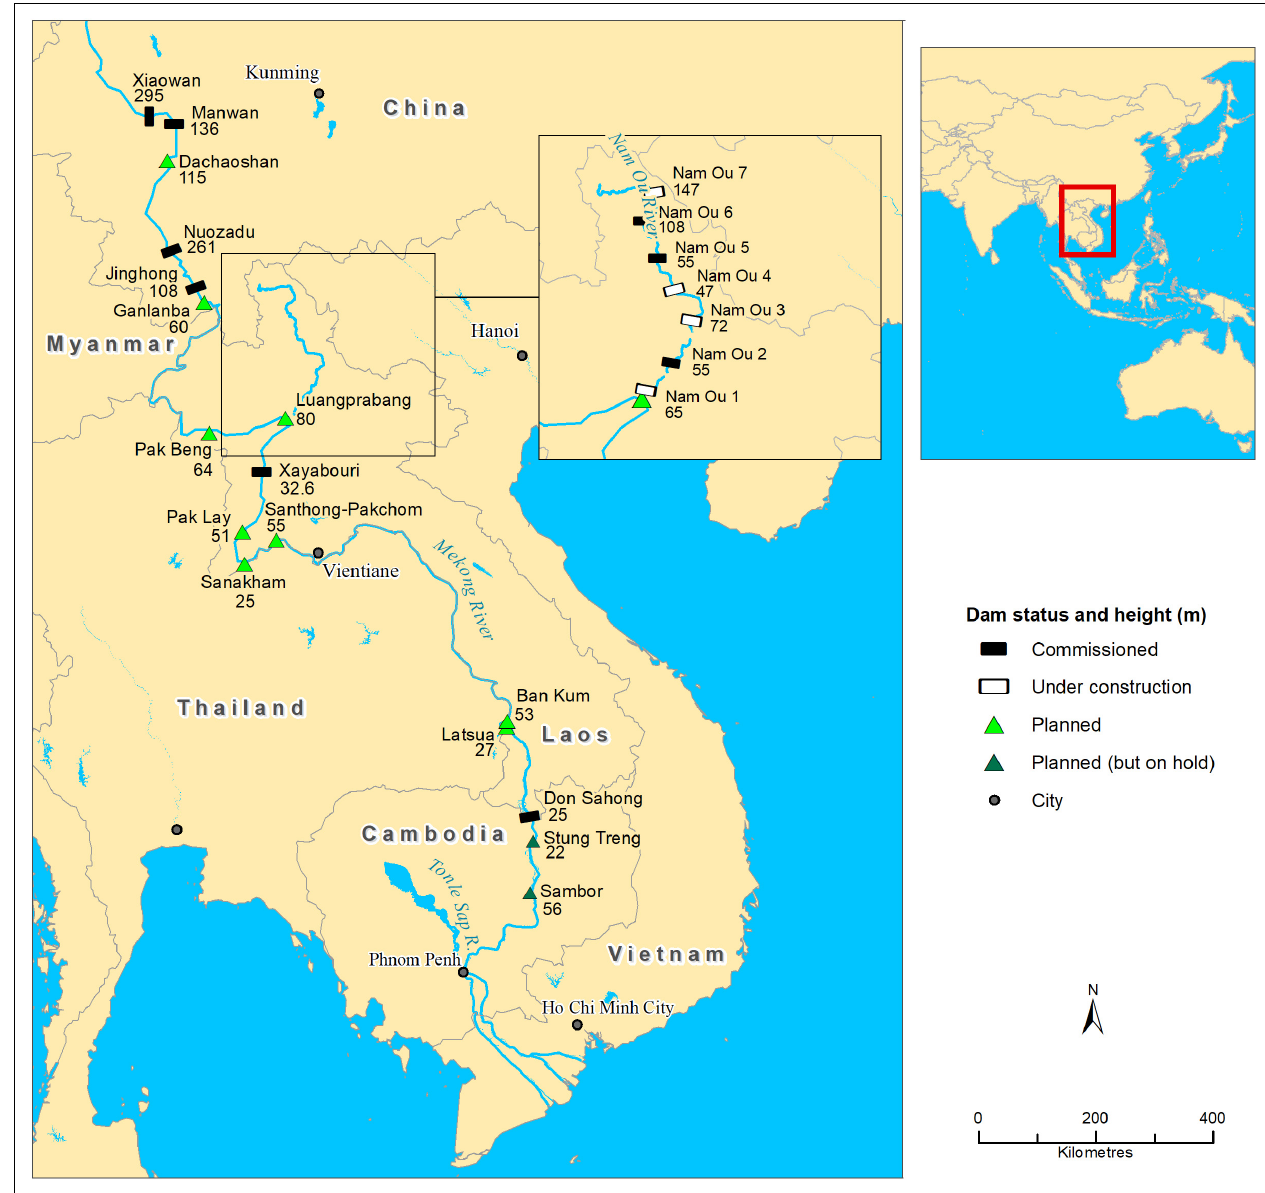
FIGURE 1 | Location of hydropower dams on the mainstream of the Mekong River and on the Nam Ou River. The dam height data are from the Greater Mekong Dams Observatory.